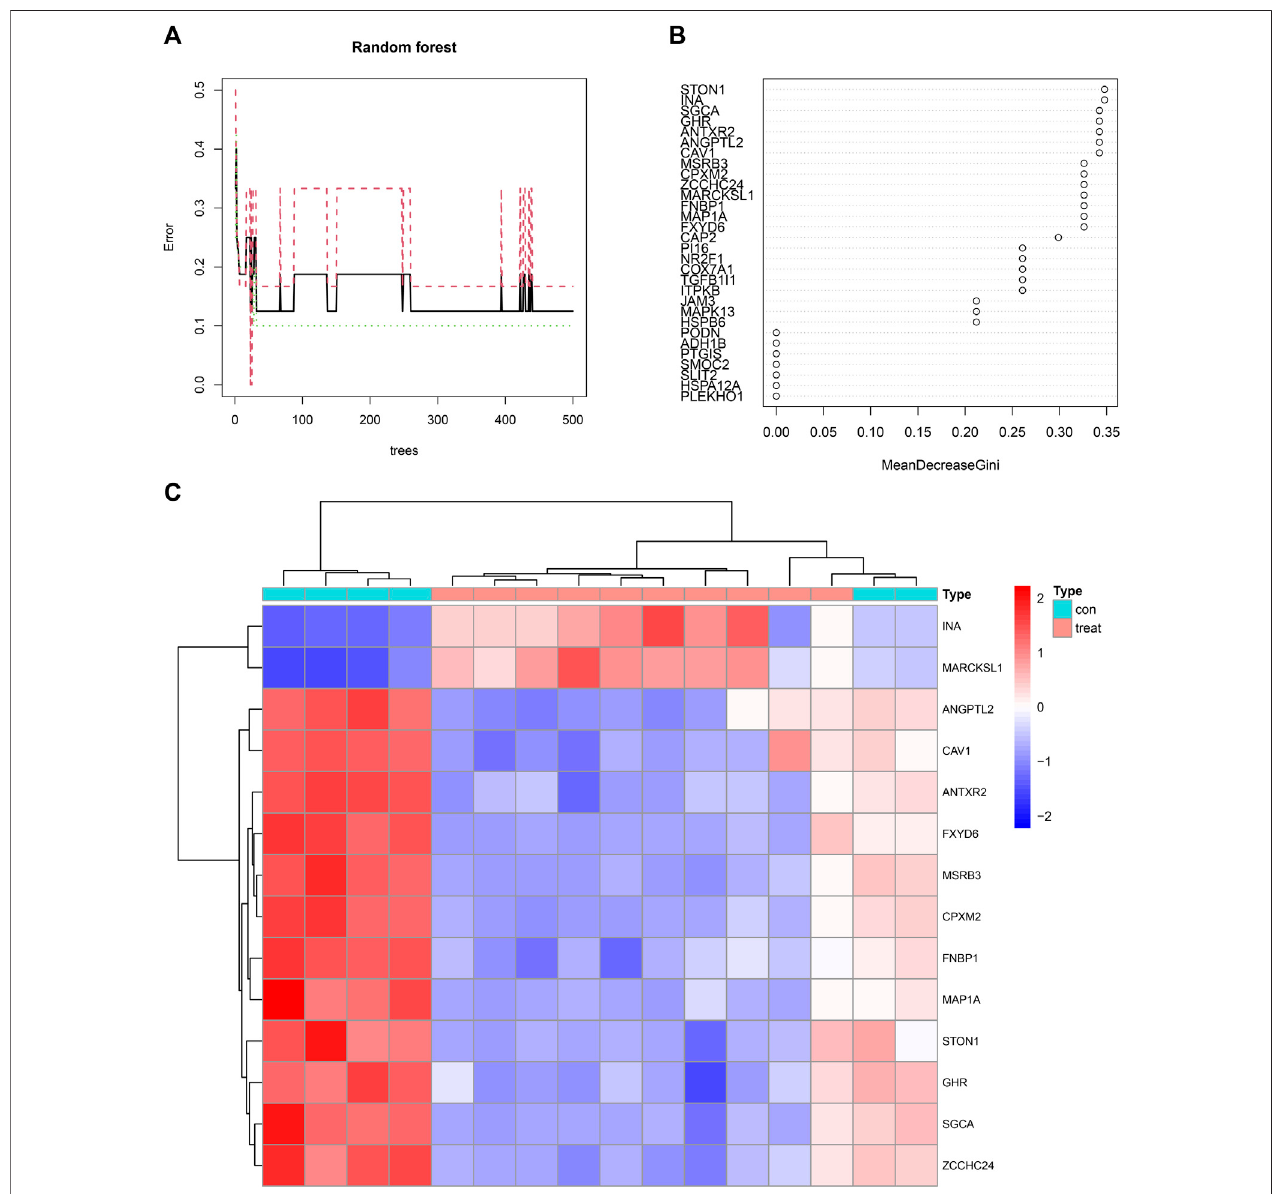
FIGURE 6 | (A) A random forest map emphasizing the minimum point of cross-validation error in the process of fi ltering feature genes. The X-axis represented the number of trees and the Y-axis represented the error of cross-validation. The green curve represented the error of the treatment group. The red curve represented the error of the control group. The black curve represented the error of all samples. (B) Fourteen feature genes whose importance score was > 0.30 were fi ltered out. (C) A heatmap illustrating the differences in the expression pro fi les of 14 feature genes between the control and treatment groups.